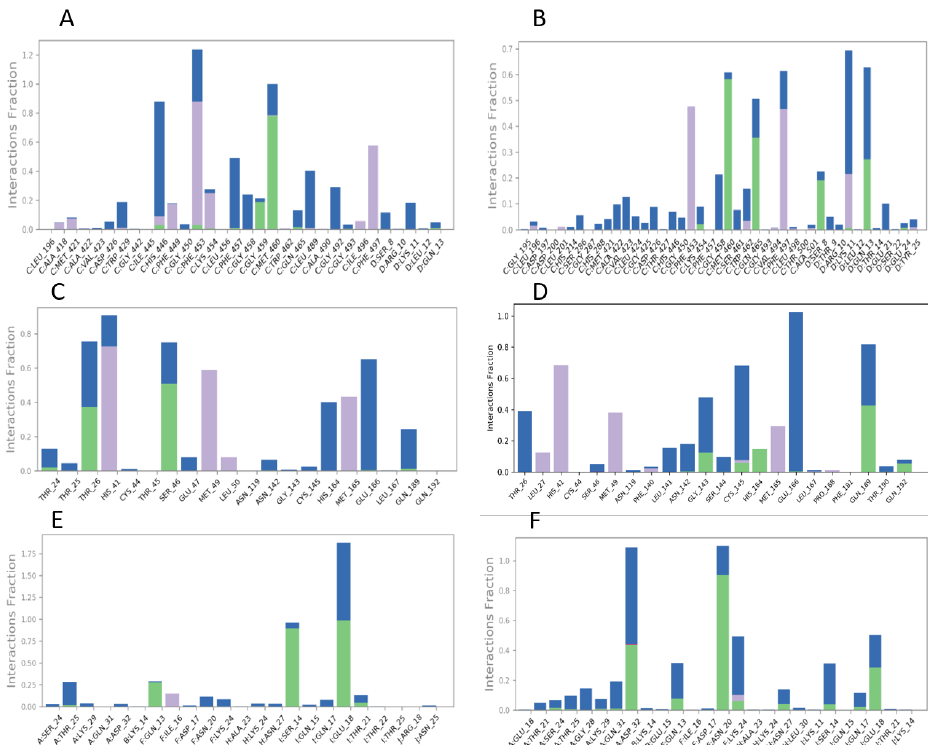
Figure 3. Protein–ligand contacts. ( A , B ): Nintedanib and Baricitinib on ACE2 Protein, PDBID: 6M1D; ( C , D ): Nintedanib and Darunavir on M pro , PDBID: 5R82; ( E , F ): Nintedanib and Quercetin on